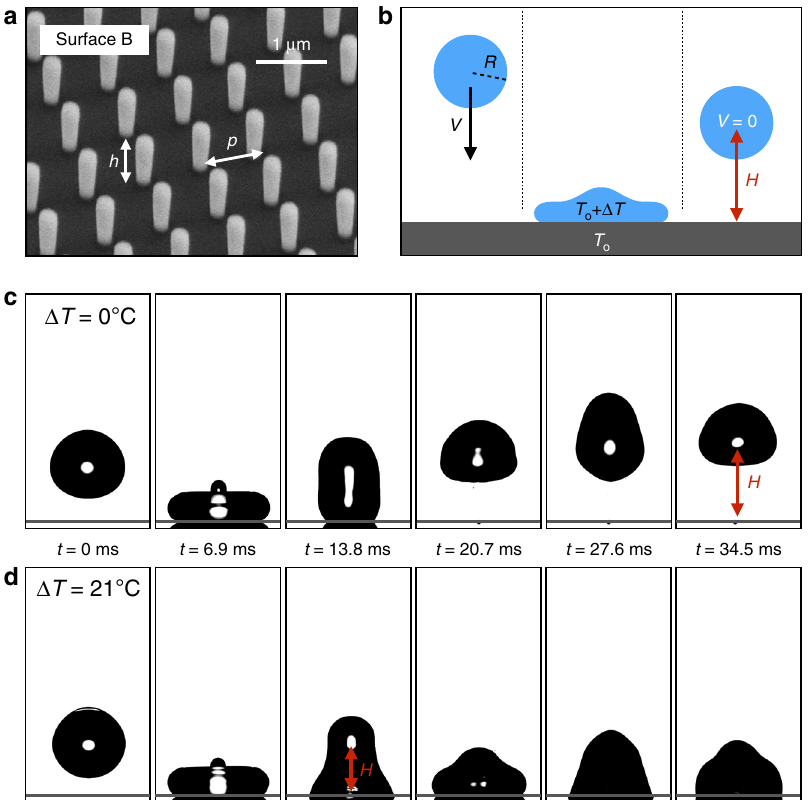
Fig. 1 Impact of hot drops on textured solids. a Scanning-electron viewgraph of substrate B. It is covered by pillars with height h = 900 nm spaced by p = 840 nm. Scale bar, 1 µ m. b Schematic of the experiment: a water drop with radius R and temperature T o + Δ T impacts at velocity V a superhydrophobic substrate kept at T o . We measure the height H reached after impact, from which we deduce the restitution coef fi cient ε of the shock. c , d Snapshots of water drops ( R = 1.4 mm) impacting the substrate B at V = 40 cm s − 1 . Images are separated by 6.9 ms and the temperature difference Δ T between the drop and the substrate is either 0°C ( c ) or 21 °C ( d ). Water bounces in the fi rst case and gets stuck in the second